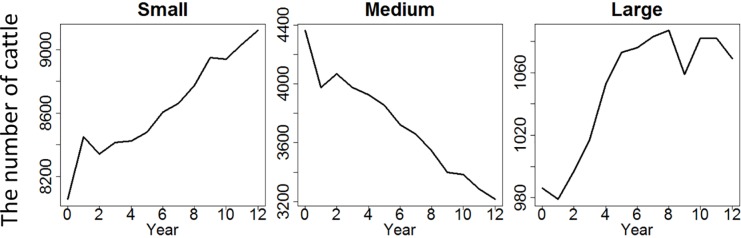
The number of small, medium and large sized cattle farms in Scotland from 2000 to 2012.